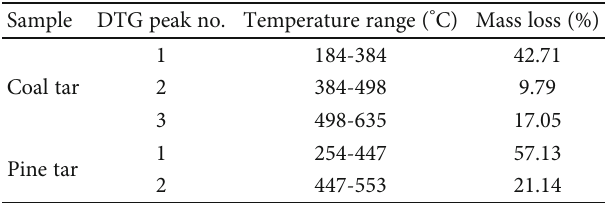
Figure 2: Thermal weight loss rate curve of test Table 1: Weight loss corresponding to various temperature.